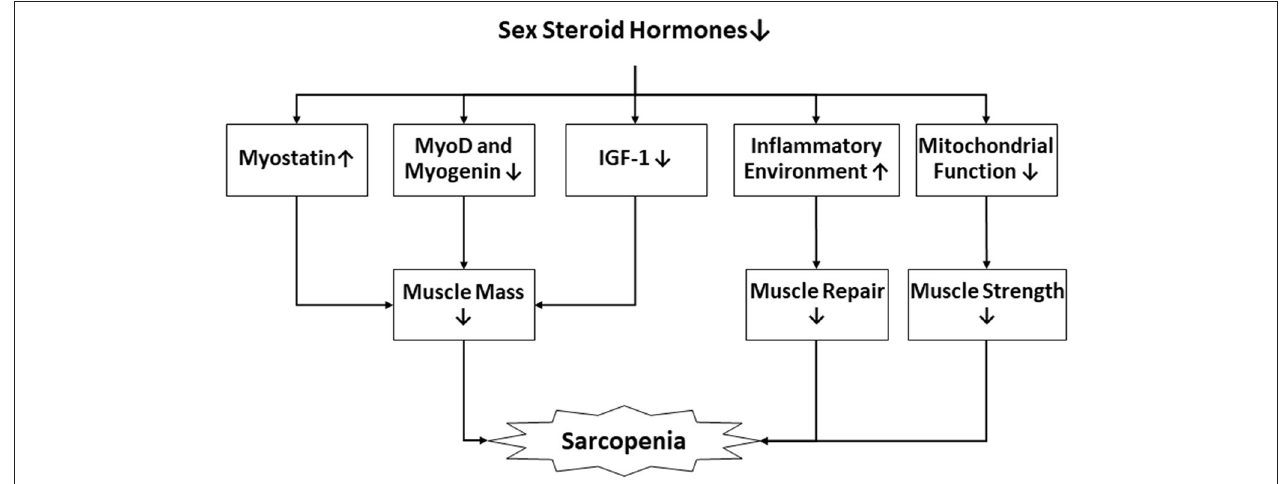
FIGURE 1 | The interactions between sex steroid hormones and sarcopenia. IGF-1, Insulin-like growth